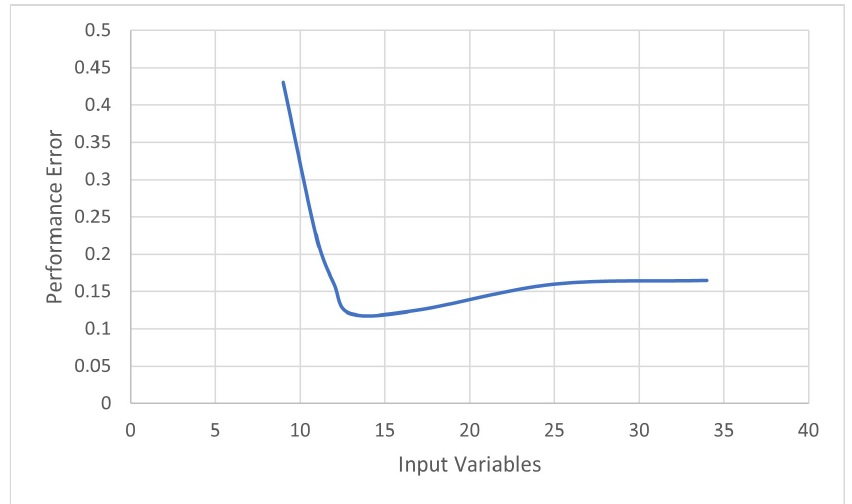
Figure 8. Number of input variables versus performance error with 10-5-1 network